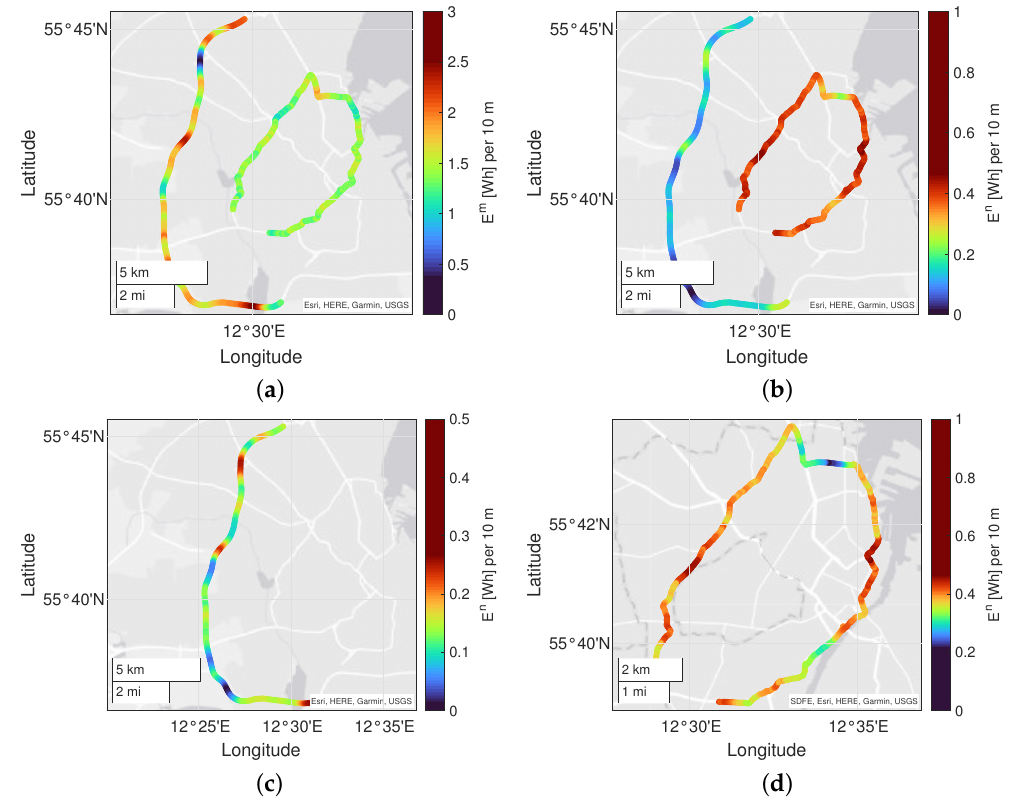
Figure 13. Mapping and visualization of average energy consumption data from ten car passes on highway road M3 and urban ring road O2: ( a ) total traction energy consumption, ( b ) normalized energy consumption, ( c ) normalized energy consumption on the highway road and ( d ) normalized energy consumption on the urban